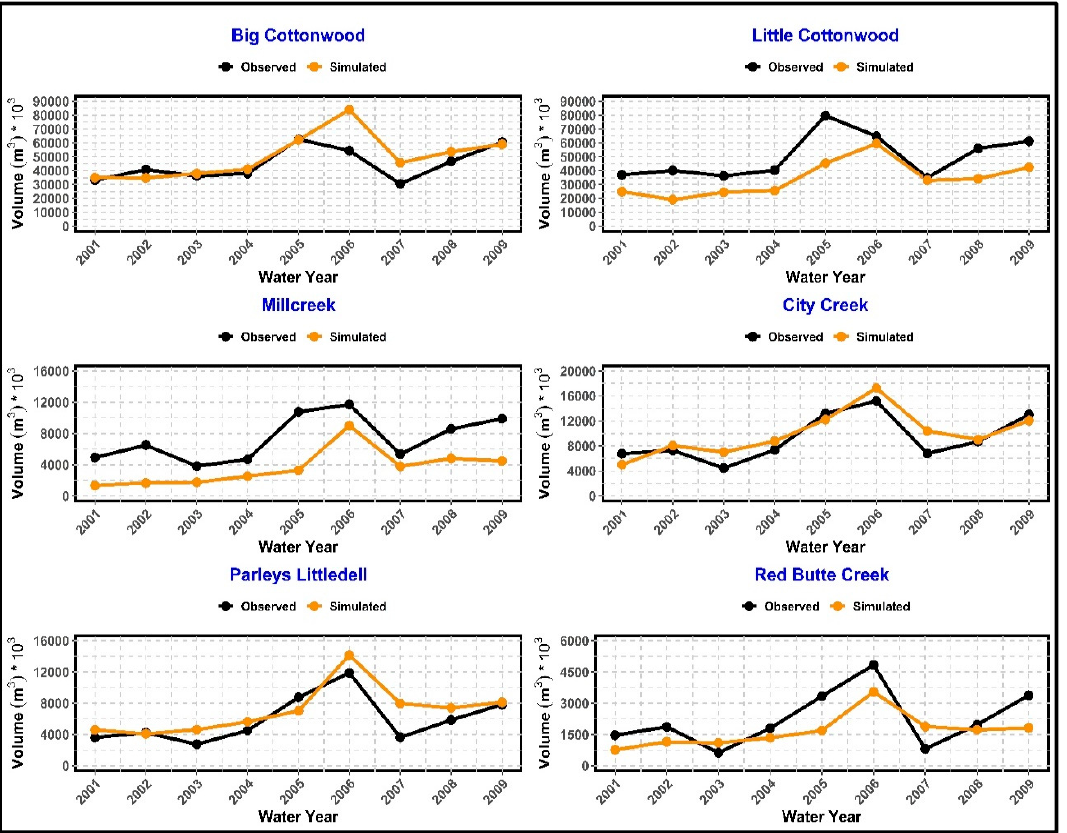
Figure 9. Observed and simulated volume of peak seasonal flow of the studied watersheds .